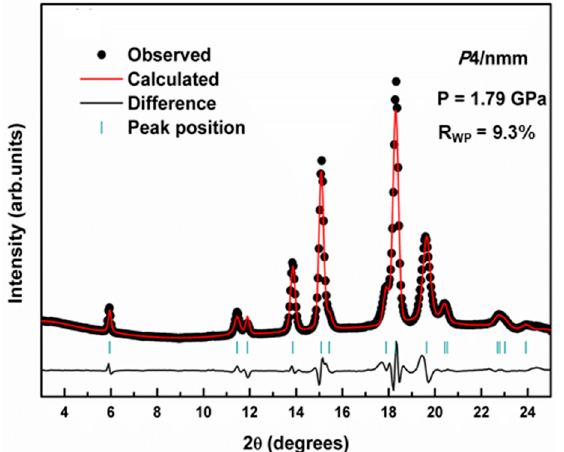
Figure 4. Rietveld refined XRD patterns of Fe 2 As at 1.79 GPa.